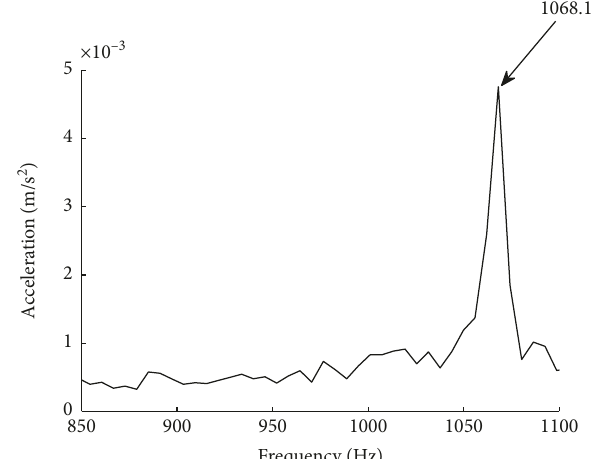
Figure 13: The acceleration-response spectrum corresponding to effective tension 522.6kN. (cid:31)